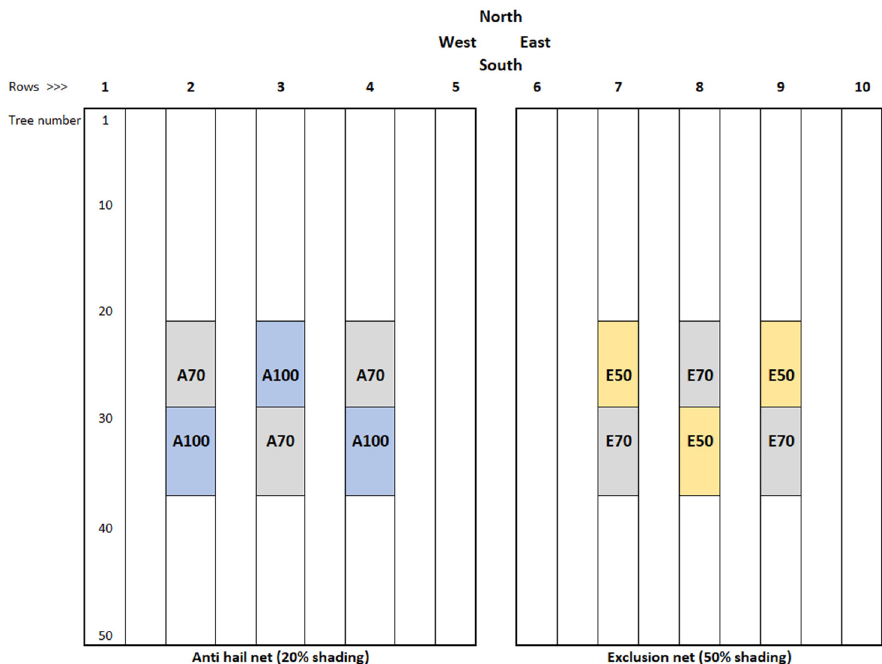
Figure 1. Simplified field trial map. Trees not in trial received 100% Et 0 .